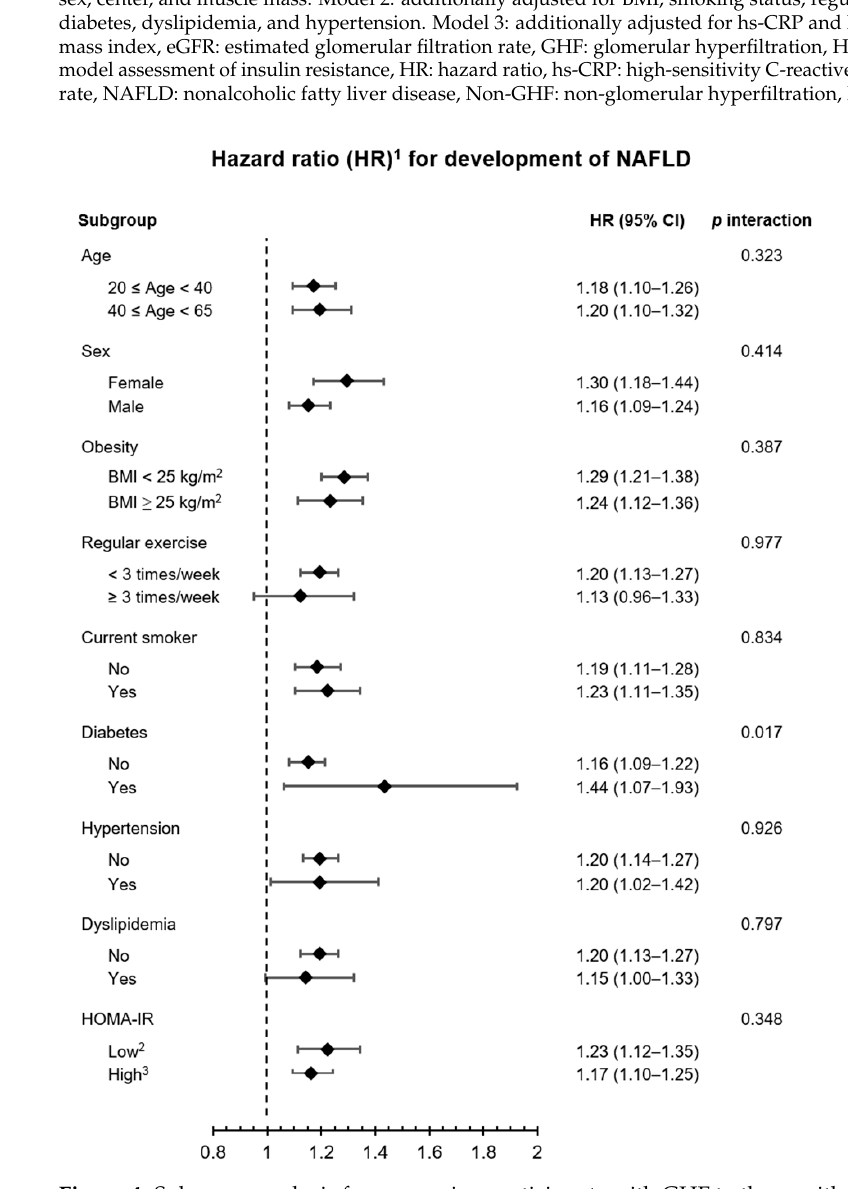
Figure 4. Subgroup analysis for comparing participants with GHF to those without GHF at baseline. 1 Adjusted for age, sex, muscle mass, BMI, smoking status, regular exercise, diabetes, dyslipidemia, hypertension, hs-CRP, and HOMA-IR. 2 Low HOMA-IR was defined as the value of <50 percentile of study participants. 3 High HOMA-IR was defined as the value of ≥ 50 percentile of study partici- pants. GHF was defined as an eGFR value of ≥ 95th percentile of study participants in each stratified group. BMI: body mass index, eGFR: estimated glomerular filtration rate, GHF: glomerular hyper- filtration, HOMA-IR: homeostasis model assessment of insulin resistance, hs-CRP: high-sensitivity C-reactive protein, NAFLD: nonalcoholic fatty liver disease.